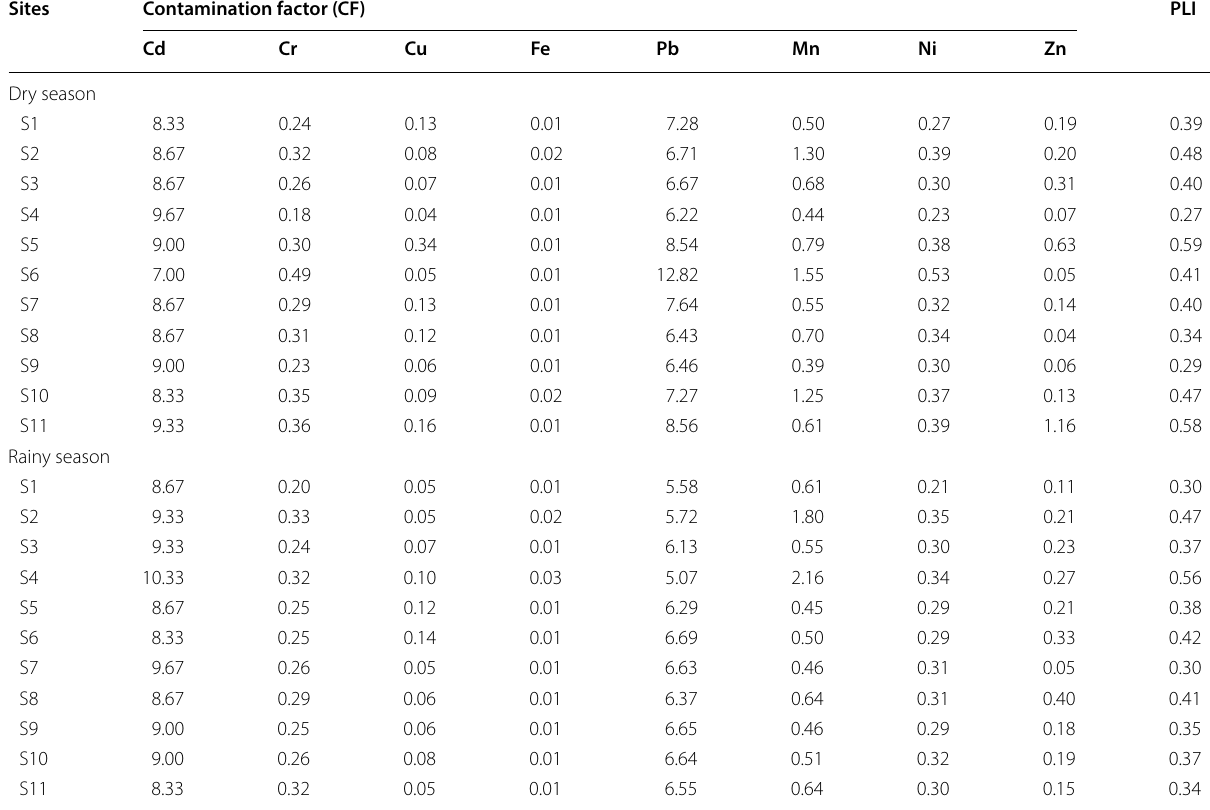
Table 8 Contamination factor (CF) and pollution load index (PLI) for trace elements in sediments